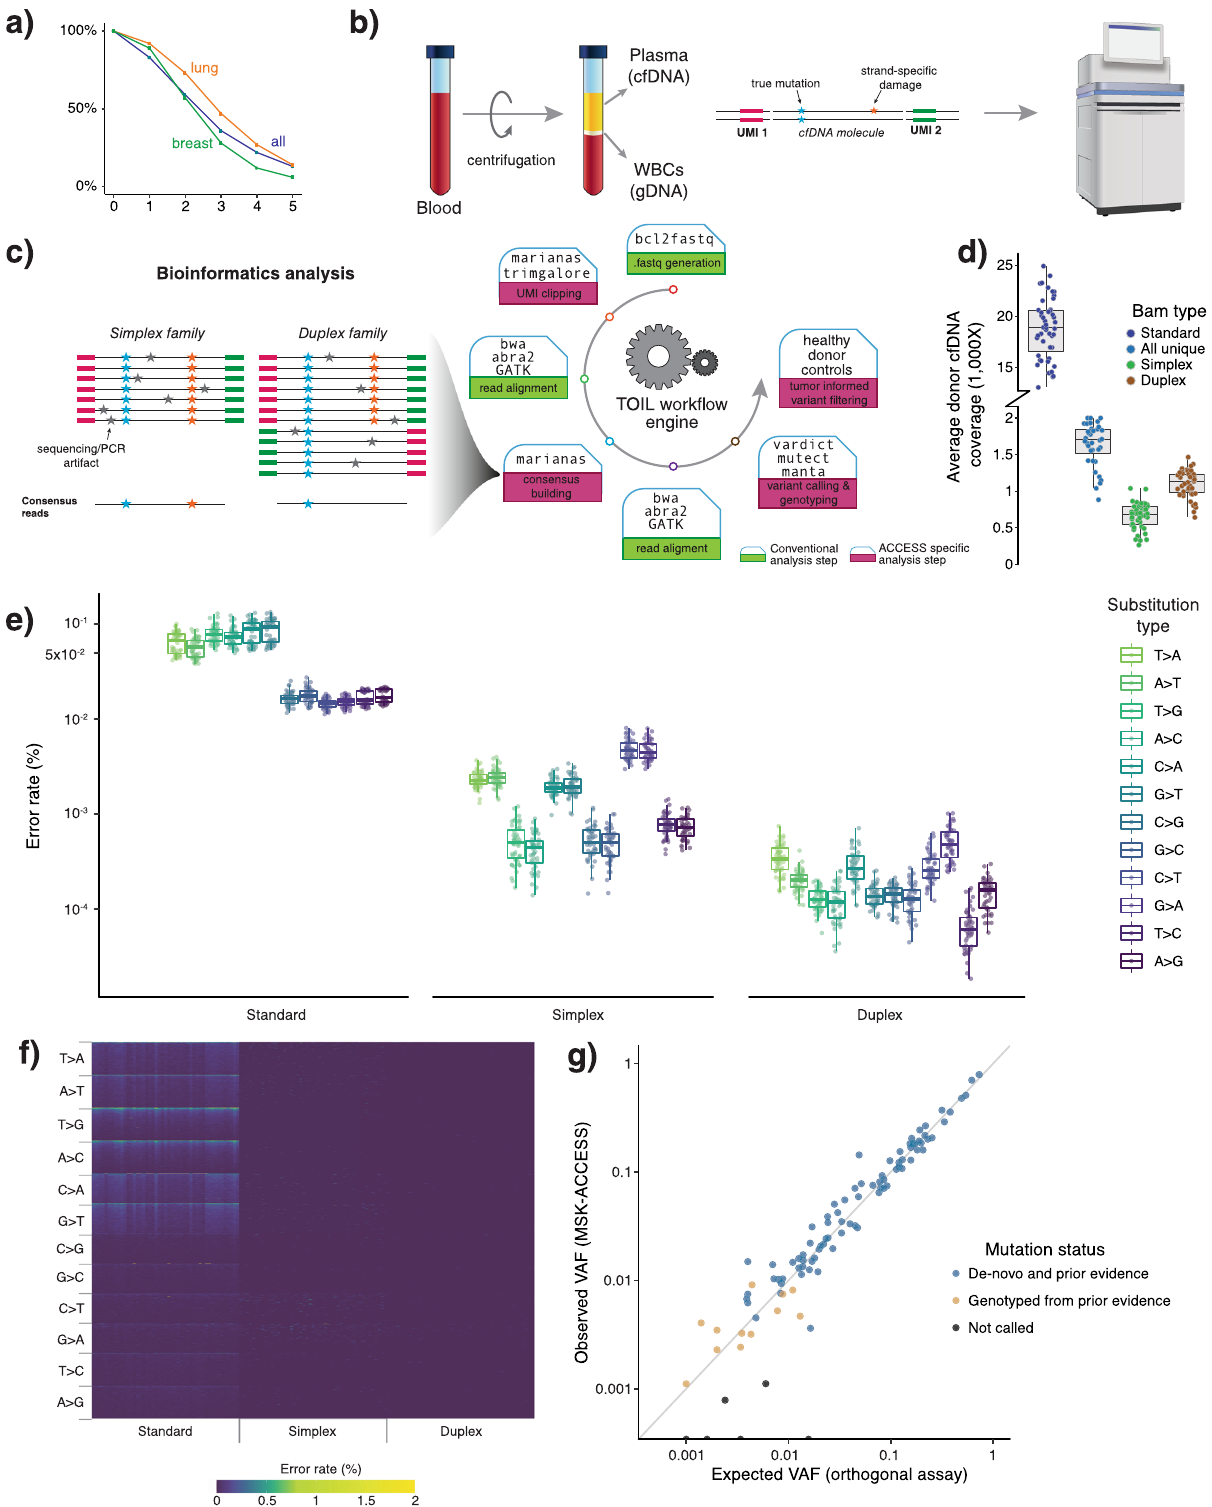
Amongst the undetected mutations, leftover DNA was available for only one of the samples (orthogonal VAF = 0.16%), and ddPCR testing of this sample revealed no evidence of the alteration in our specimen. For mutations with VAF ≥ 0.5% from orthogonal assays ( n = 83), we called 92% ( n = 76, 95% CI: 84 – 96.5%) de novo, and we detected 99% of the mutations by genotyping ( n = 82, 95% CI: 92.5 – 99.9%).